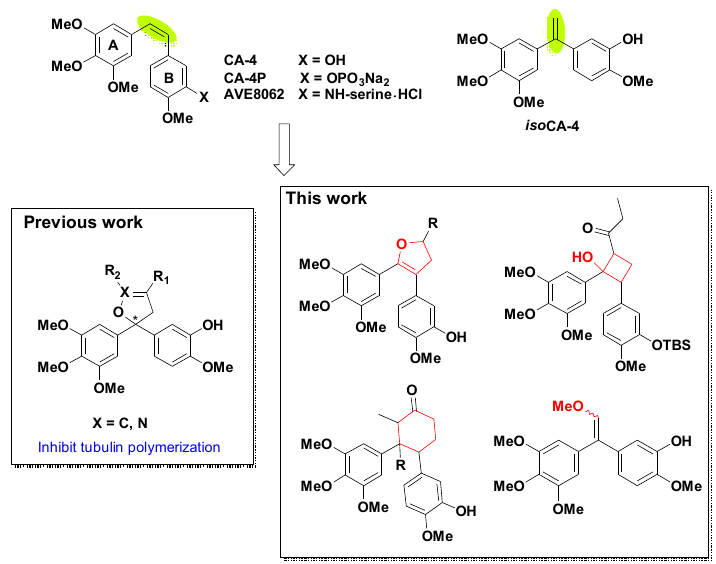
Figure 1. The structures of CA-4 and synthetic prodrugs, iso CA-4 and designed analogues.